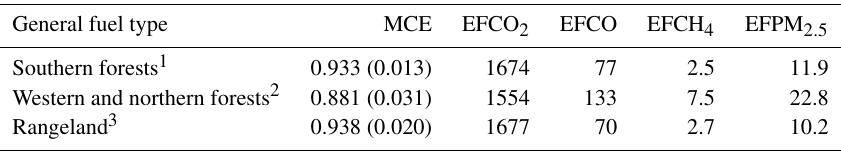
Table 9. Best-estimate MCE and EF (gkg − 1 ) for generalized fire types from multiple field studies. The standard deviation for MCE is provided in parentheses. EFs are based on the linear fits in Table 8 at the fire type average MCE value. The MCE values are from Urban- ski (2014).